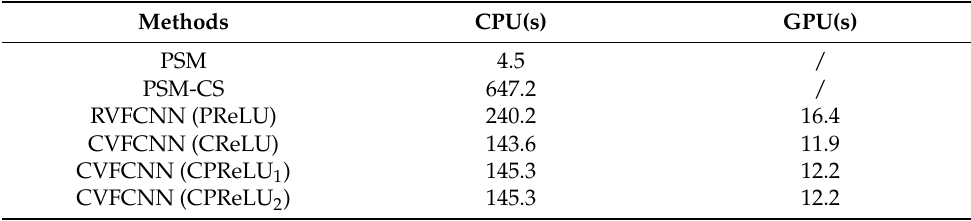
Table 6. Processing-time comparison of measured